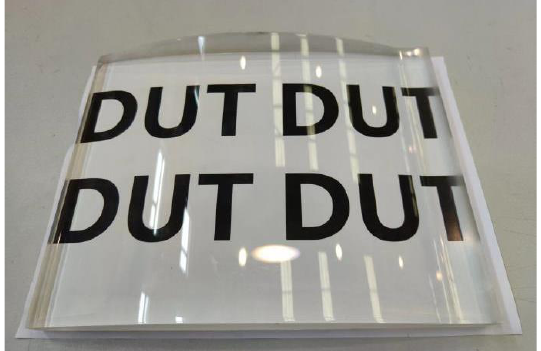
Figure 14. The actual effect of the complex curved plexiglass part after polishing.